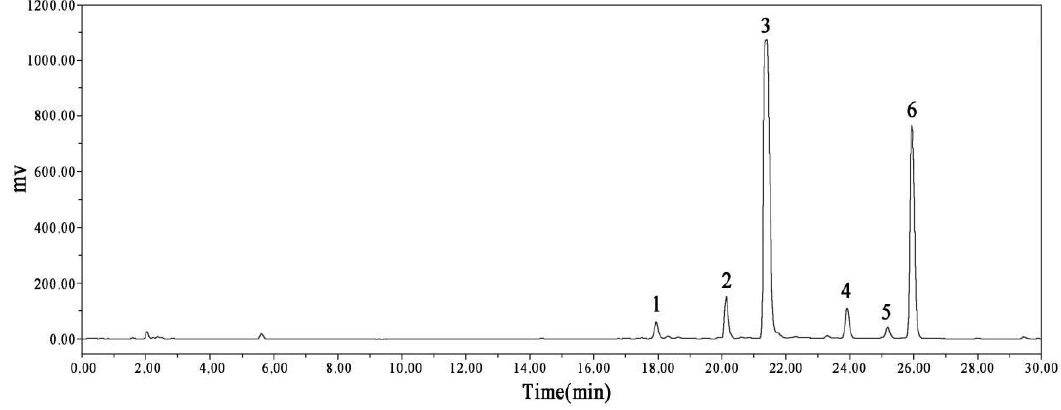
Figure 1. Inhibitory effect of the SME on H8 cells.